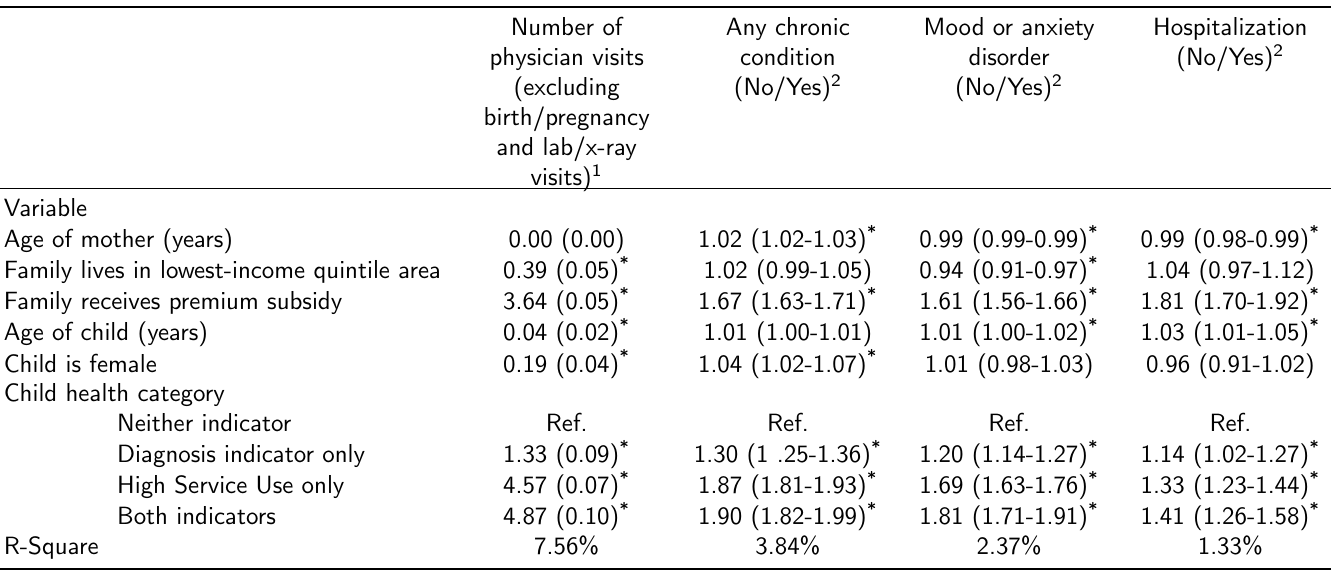
Table 4: Beta estimates (standard errors) and odds ratios (95% confidence intervals) from regression analyses predicting